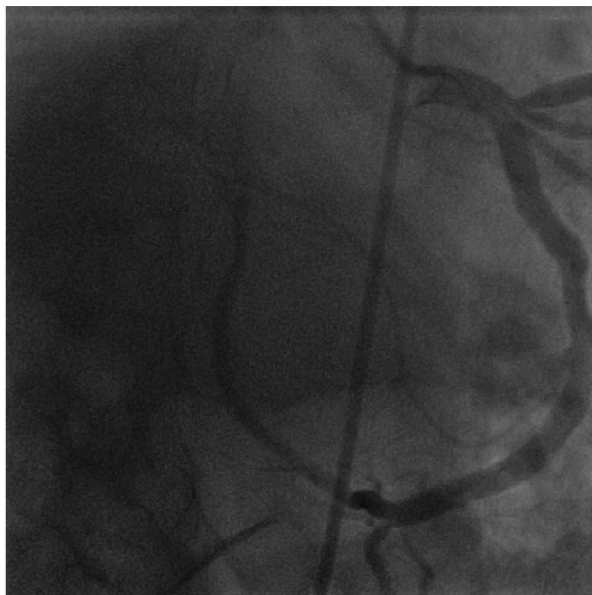
Figure 2 - The LCx was a dominant vessel, with an aberrant branch from the distal left circumflex artery that crossed the crux and continued to the right atrioventricular groove.